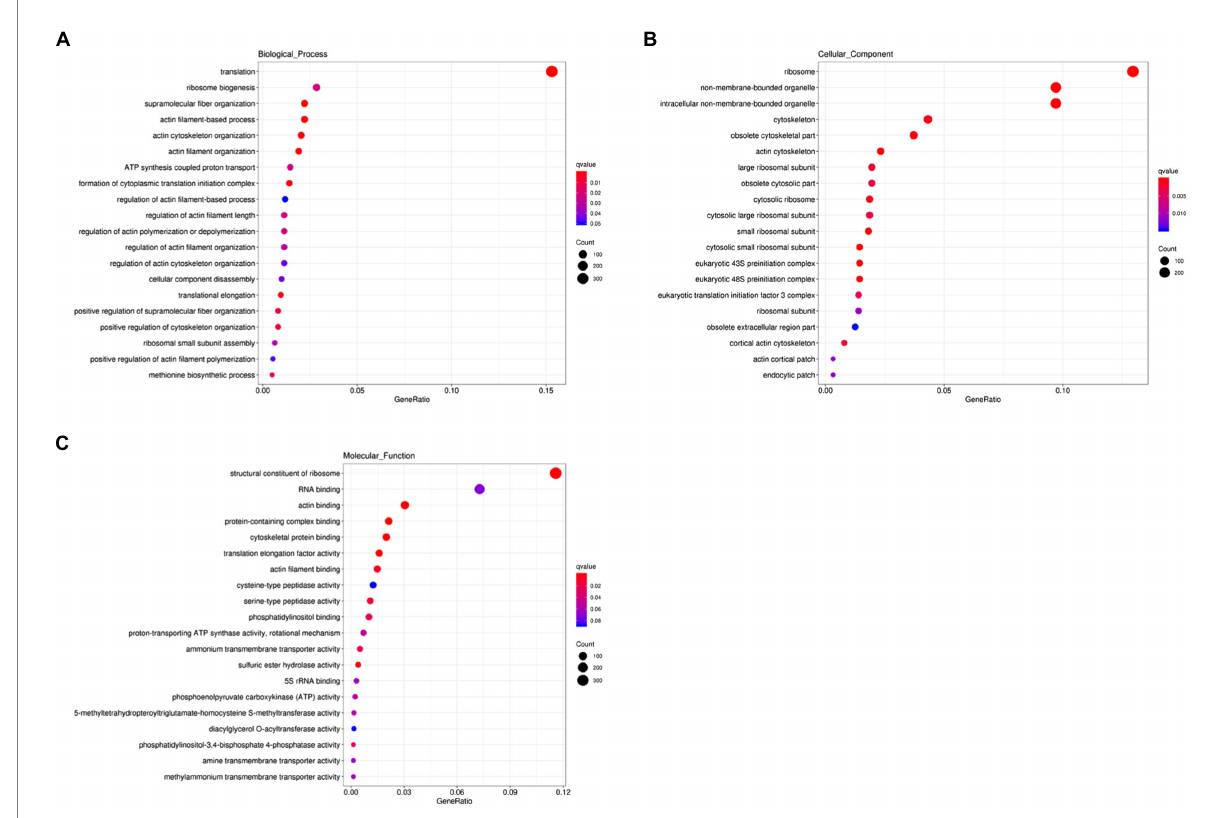
FIGURE 2 GO enrichment analysis of DEGs. (A) Biological process. (B) Cellular component. (C) Molecular function. The y -axis represents the process name. The x -axis is GeneRatio, that is, the proportion of the genes of interest annotated in this item to the number of all differentially expressed